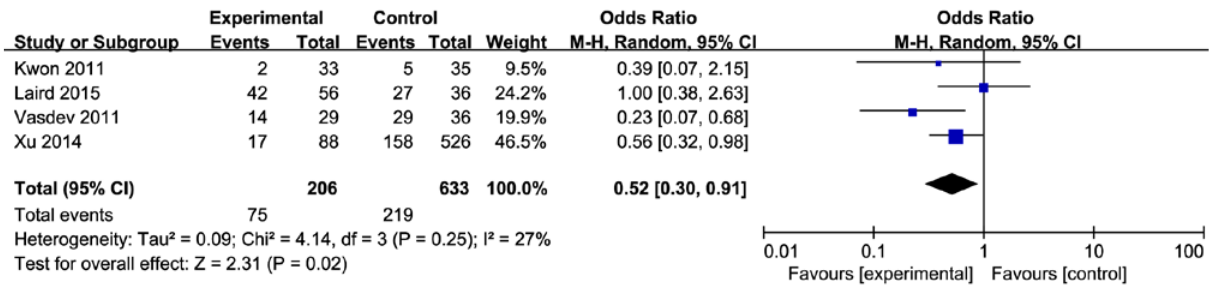
Figure 5: The forest plot for the postoperative complications between LRN and ORN